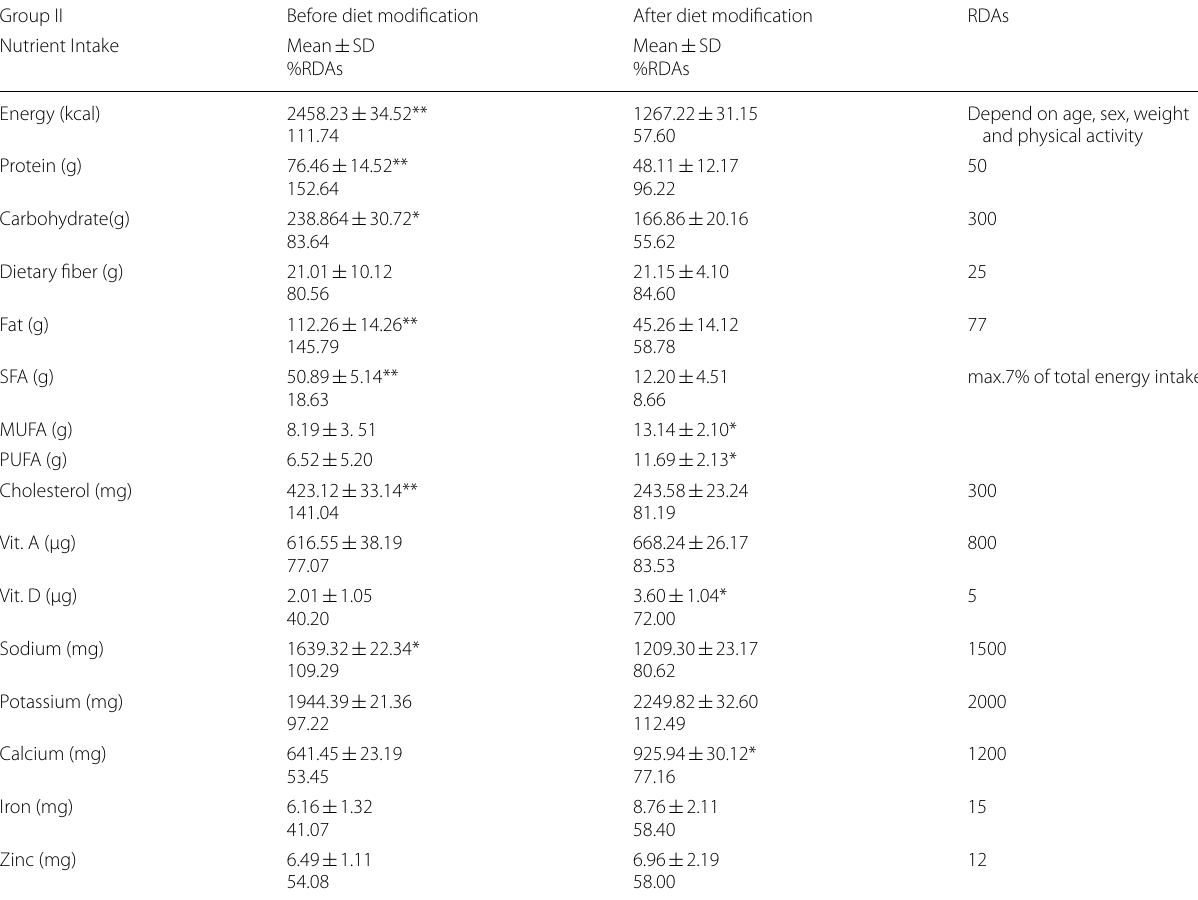
Table 4 Mean SD of the daily nutrients intake and the RDAs percent for women on group ±